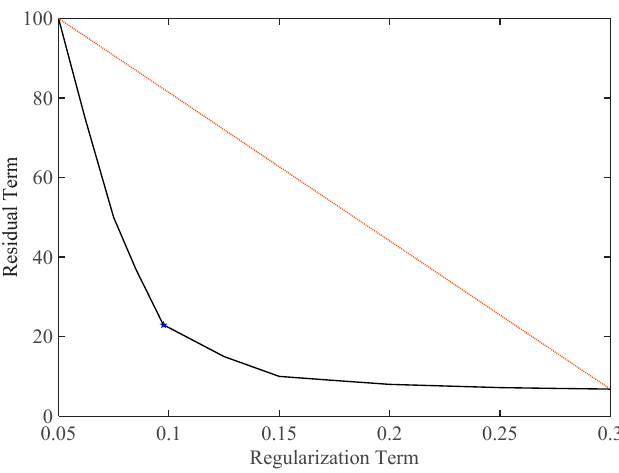
Figure 1. Optimal regularization parameter on the L-curve.